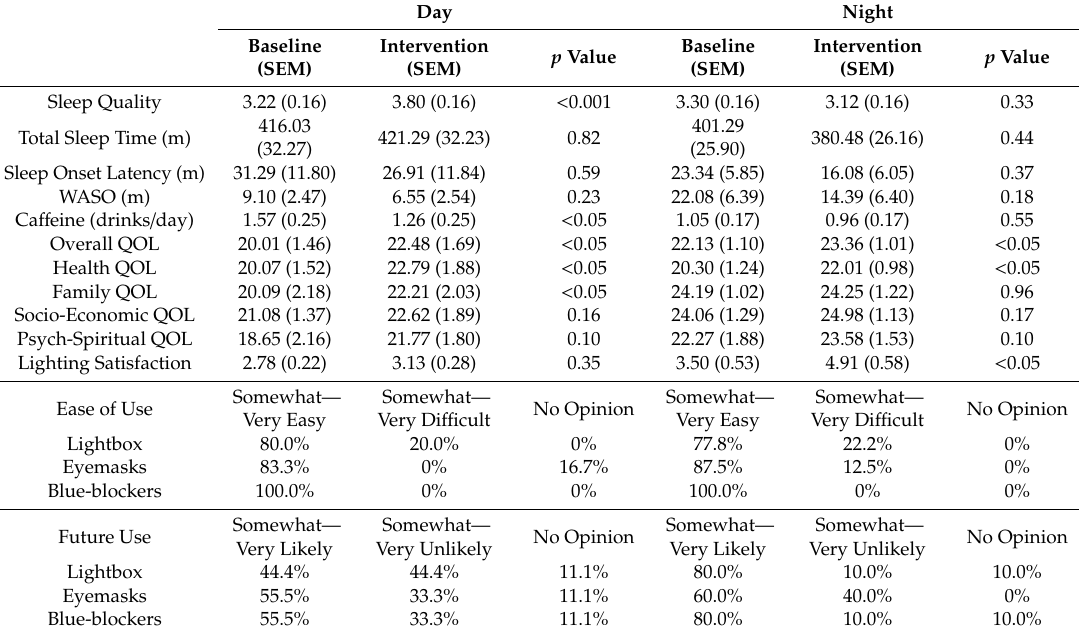
Table 1. Table of self-reported e ff ectiveness and implementation